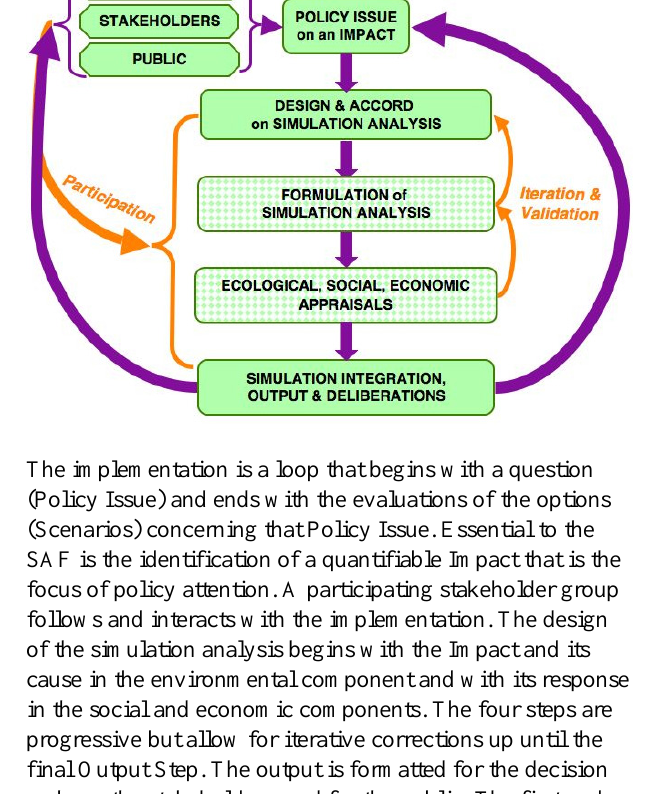
Fig. 6 . Diagram of the activities and products for the